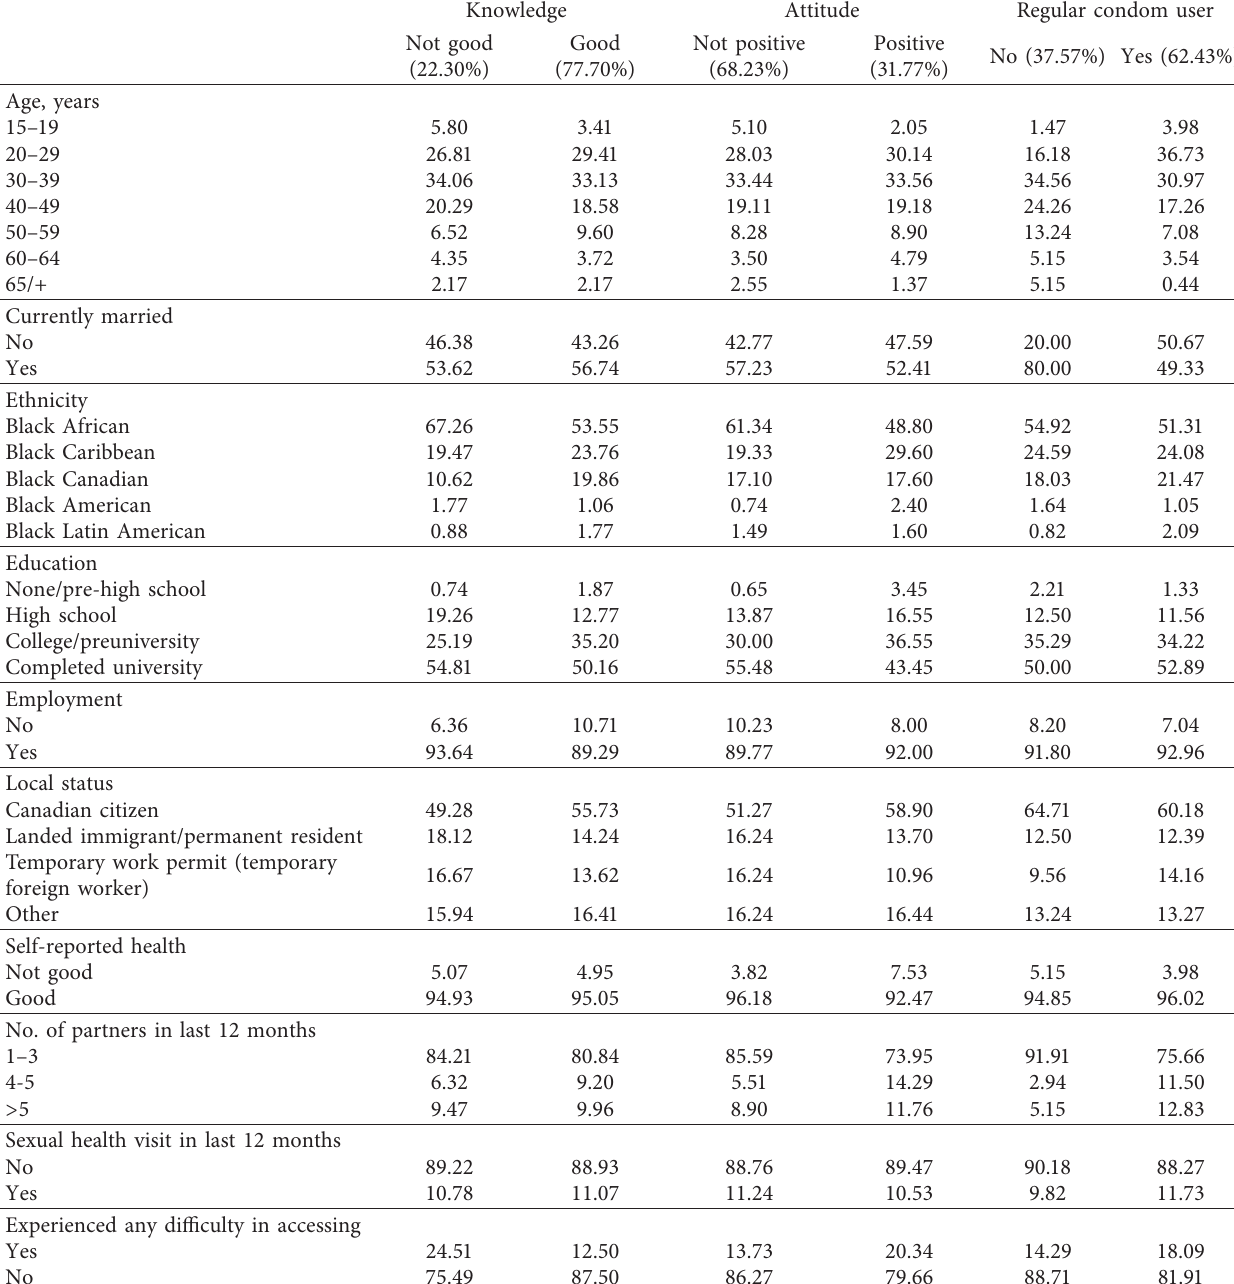
Table 1: Descriptive analysis of condom knowledge, attitude, and utilization among ACB men in Ontario. Knowledge